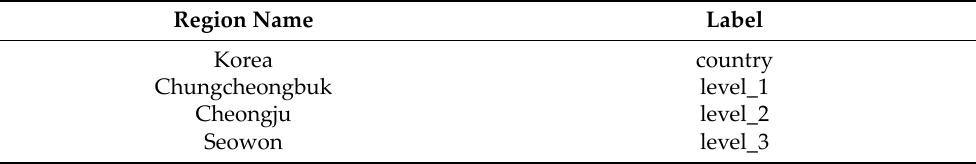
Table 1. Administrative district sample dataset (Korea).